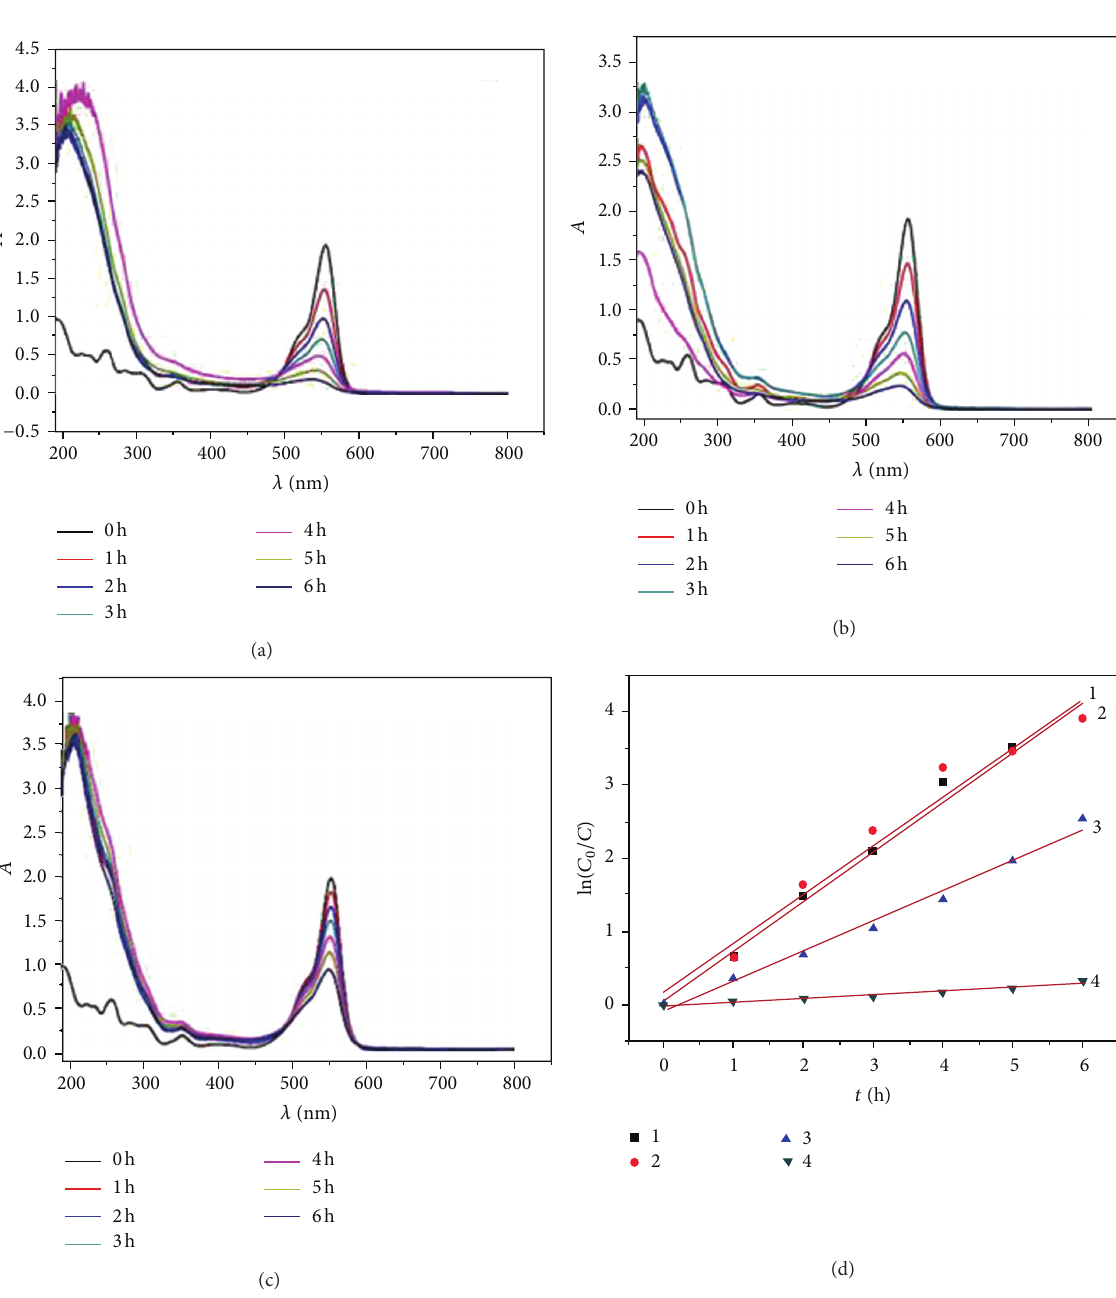
Figure 7: UV-visible absorption spectra changes of RhB with different as-prepared ZnWO 4 samples at 180 ∘ C: (a) 5min, (b) 10min, and (c) 15min. (d) Kinetics of degradation of